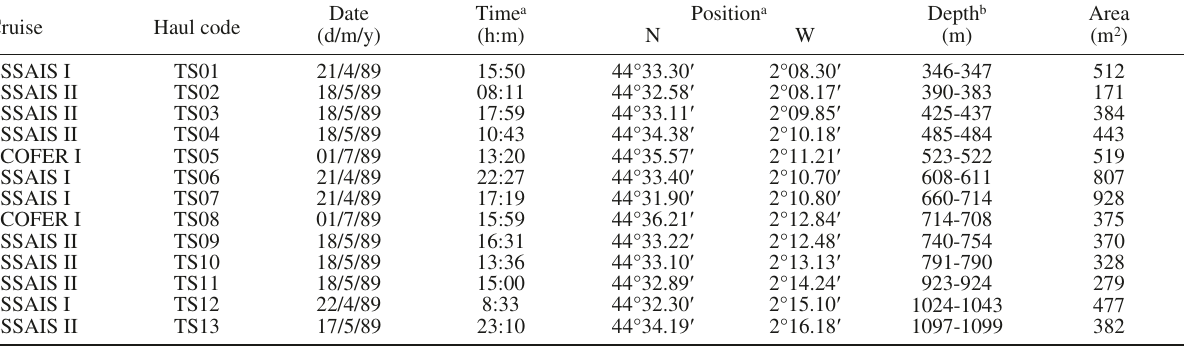
Table 1. – Haul characteristics and geographical position of stations sampled with a suprabenthic sledge on the southern margin of the Cap Ferret Canyon during the ESSAIS and ECOFER cruises. Estimated bottom area swept by the sledge during each haul (calculated from TSK flowmeter measurements). a : time and position of the boat at the beginning of the haul on the bottom; b : depth (below the boat) at the beginning and at the end of the haul on the bottom. Cruise Haul code ESSAIS I